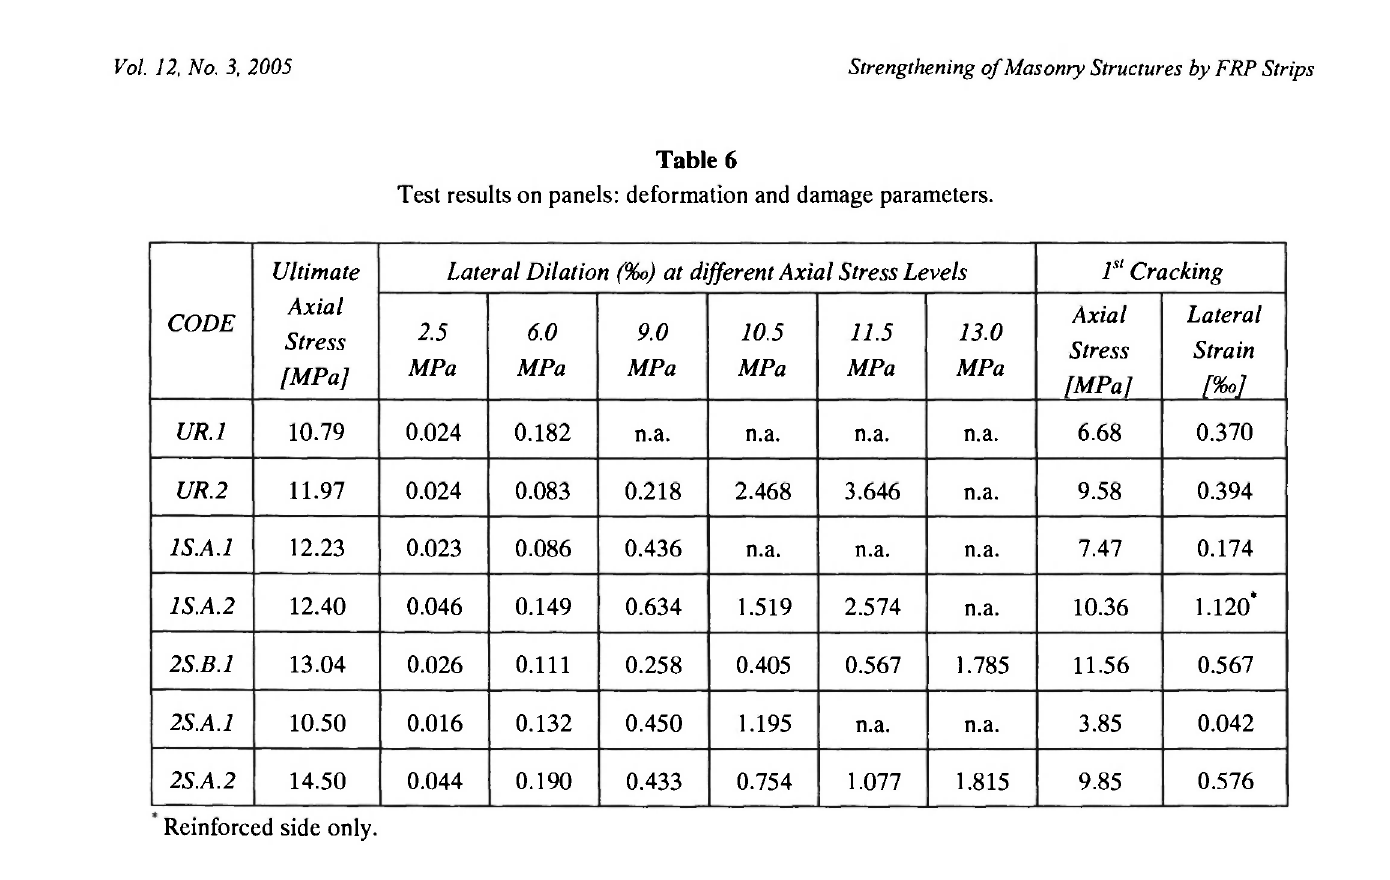
Test results on panels: deformation and damage